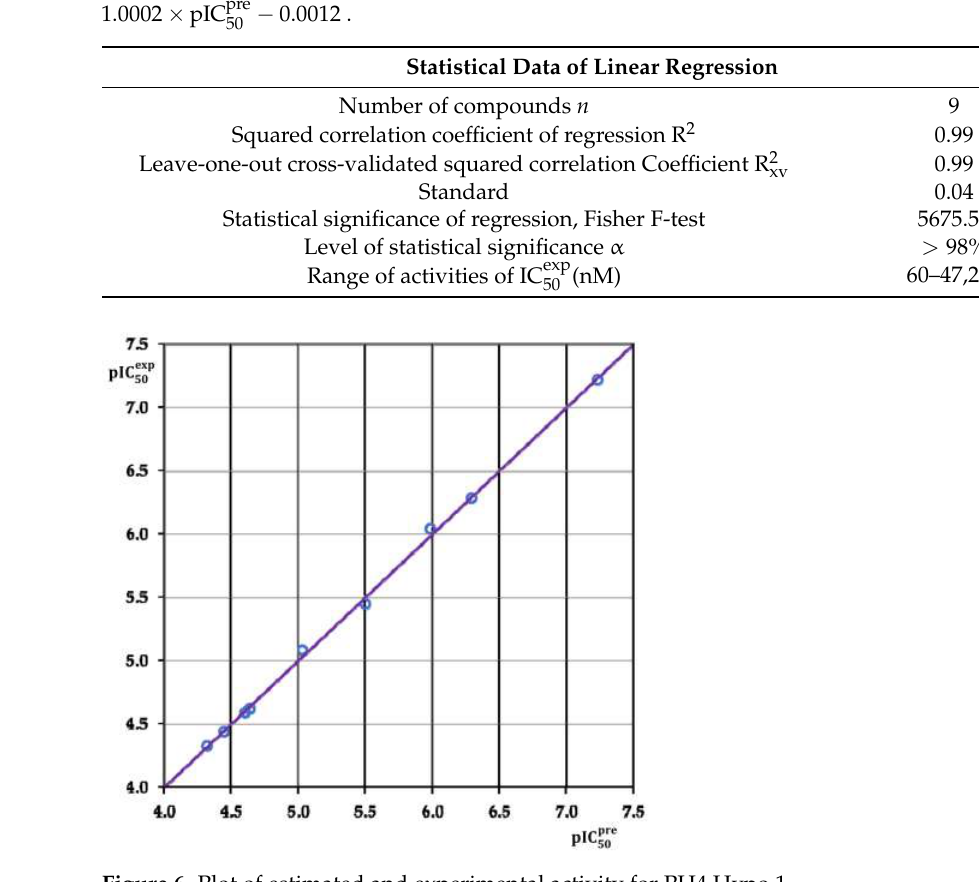
Table 5. Statistical data on regression analysis of correlation for the training set between PH4 predicted activity (pIC pre ) and experimental one (pIC exp 50